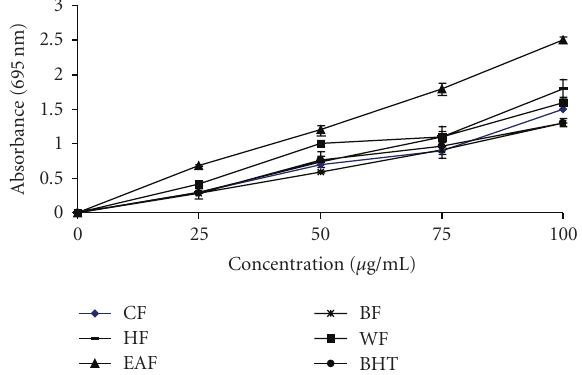
Figure 2: Total antioxidant capacity of the crude ethanol fraction (EF), hexane fraction (HF), ethyl acetate fraction (EAF), butanol fraction (BF) and water fraction (WF) from wampee peel. Higher absorbance value indicates higher antioxidant activity.